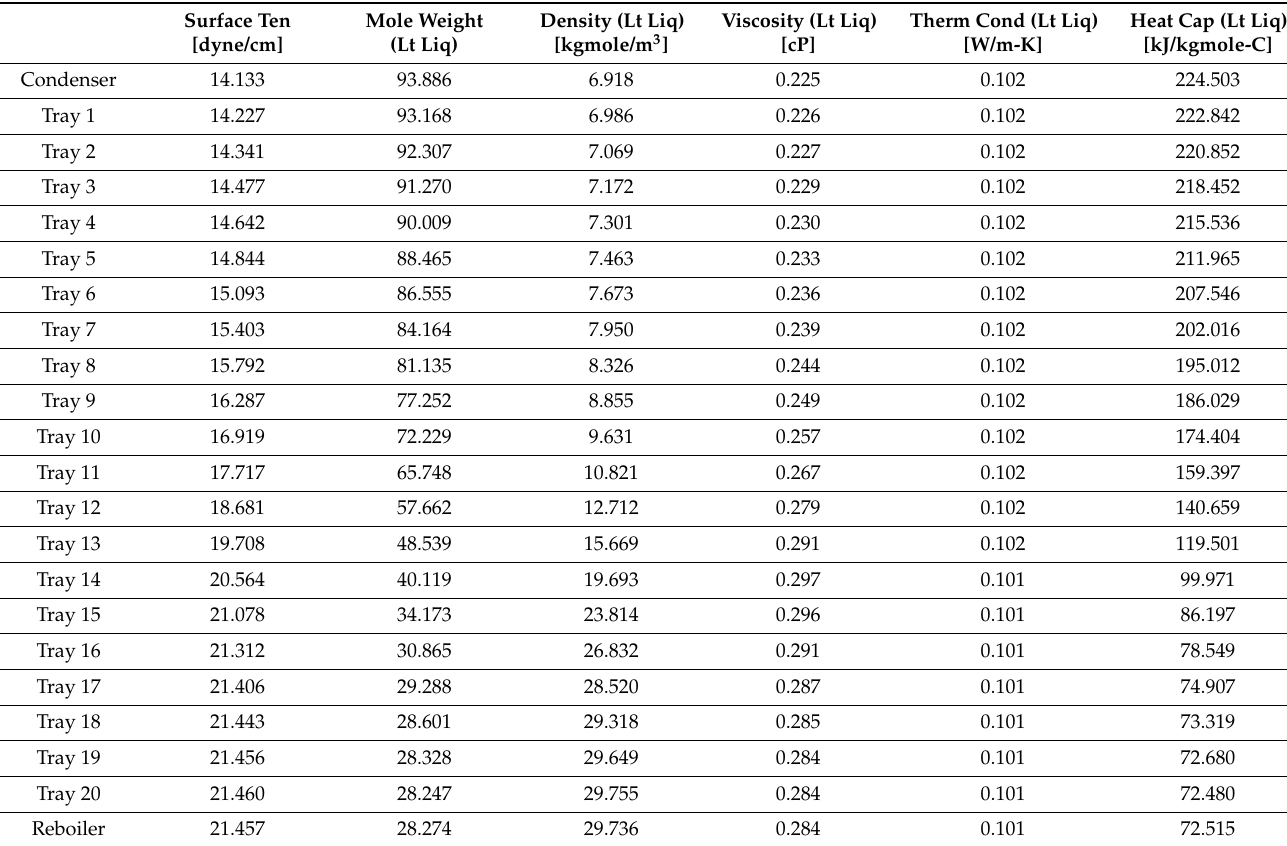
Table 11. Column properties vs. tray position from top for liquid.